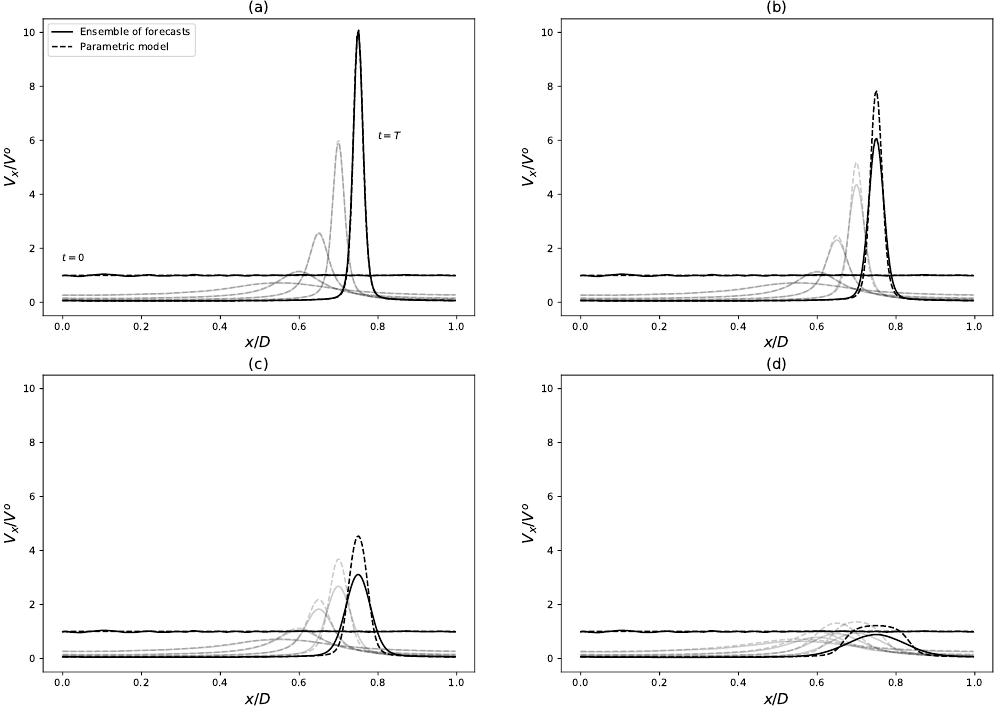
Figure 5. Parametric (dashed line) vs. ensemble estimated (continuous line) variance fields for initial perturbations of standard deviation (a) (tangent linear dyanmics), σ 0 magnitude σ 0 1% only for the times t = { 0 , 0 . 2 , 0 . 4 , 0 . 6 , 0 . 8 , 1 } T